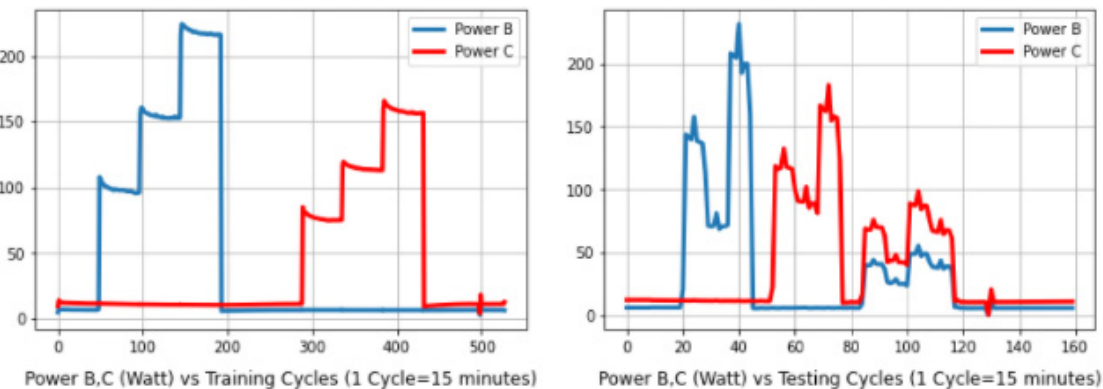
Figure 3. Long ( left ) and short ( right ) cycling processes [11].